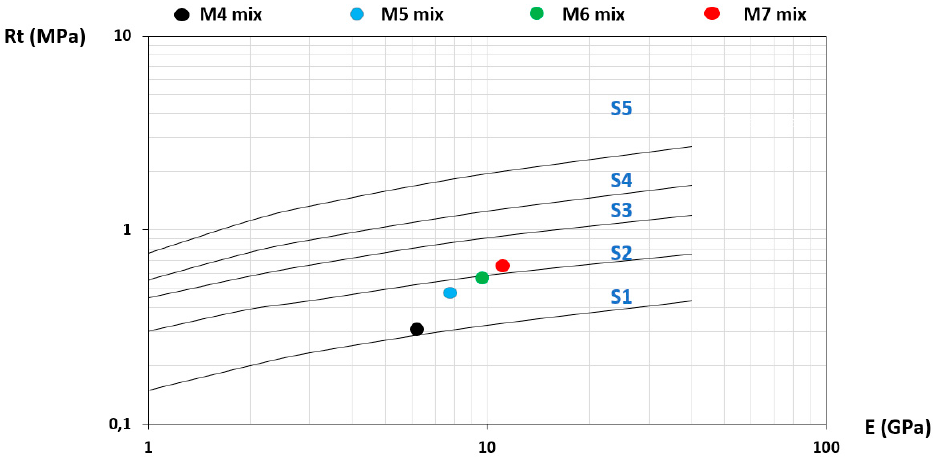
Figure 9. Structural classification of designed mixes according to NF-P98-113 [38].